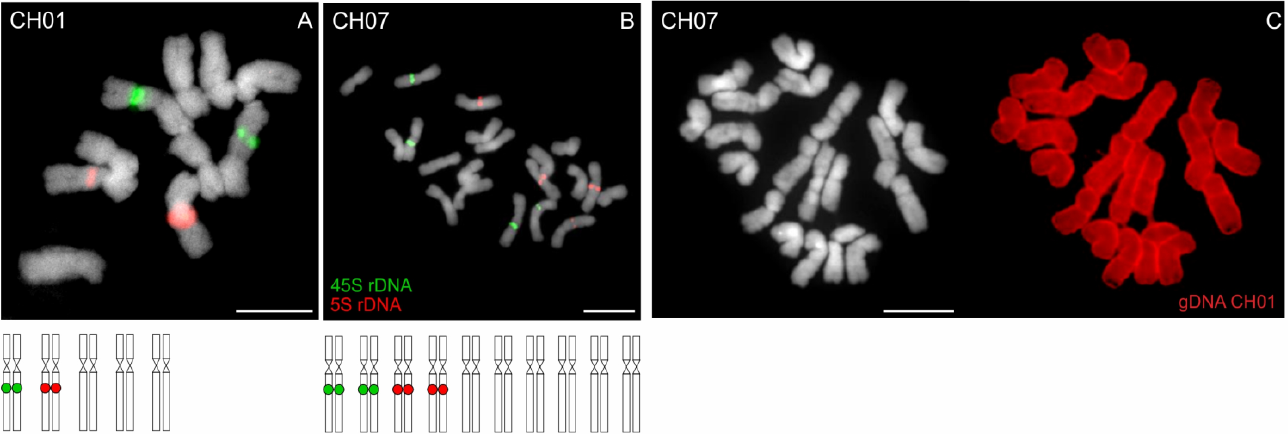
Figure 6. Chromosome localization of rDNA and GISH in Anthoxanthum alpinum. ( A ) Diploid population of A. alpinum (2n = 10; CH01 from Switzerland) exhibits one 45S- (green fluorescence) and one 5S rDNA-bearing (red fluorescence) chromosome pair. ( B ) Tetraploid population of A. alpinum (2n = 20; CH07, Supplemetary Table S1) shows exactly twice the number of rDNA loci compared to the diploid cytotype supporting an autopolyploid origin of the tetraploid. ( C ) GISH in tetraploid A. alpinum (CH07) using a probe corresponding to gDNA of diploid A. alpinum (CH01, red fluorescence) further suggests an autopolyploid origin of the tetraploid. Chromosomes were counterstained with DAPI. Scale bars, 10 µm.